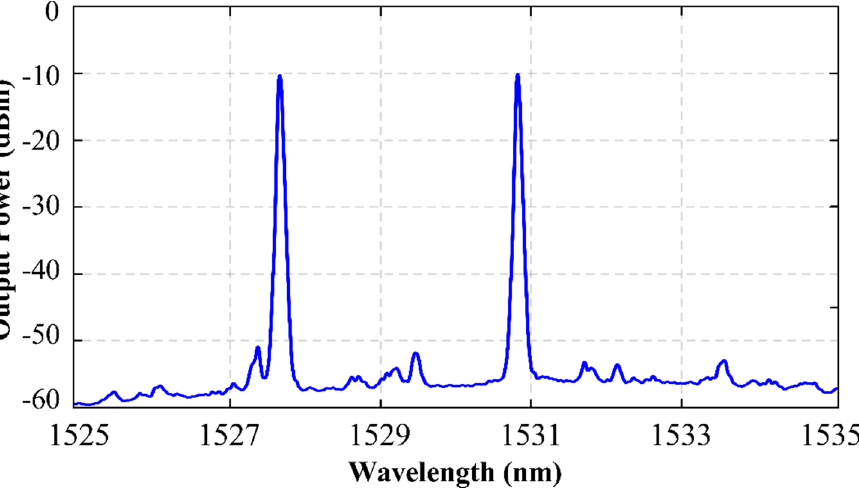
Figure 4. Output spectra of the highly equalized dual-wavelength C–band fiber laser assisted by a random reflector pumped at 150 mW and measured by an OSA.